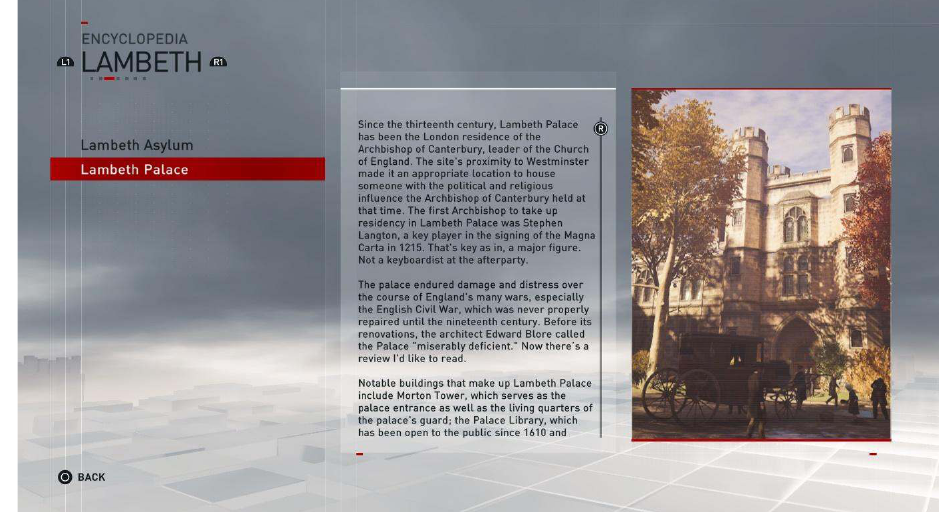
Figure 11: The in-game article for Lambeth